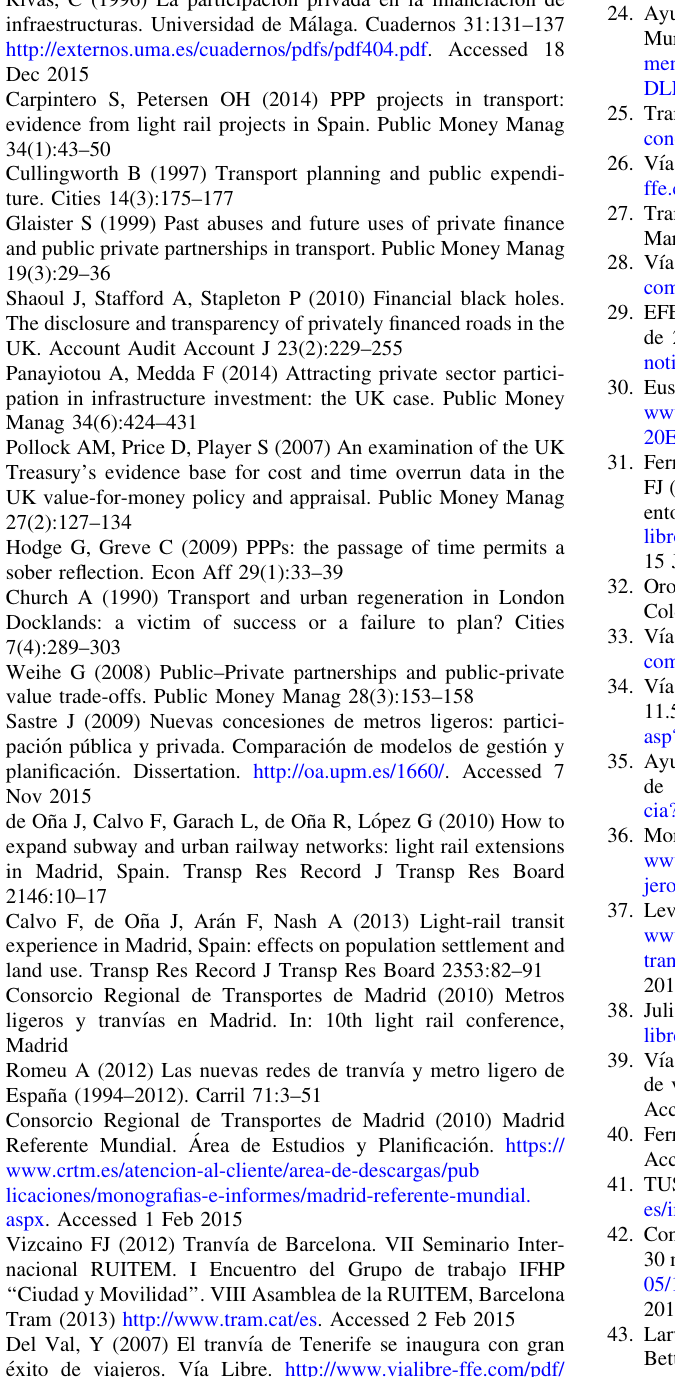
Referente Mundial. A´ rea de Estudios y Planificacio´n.